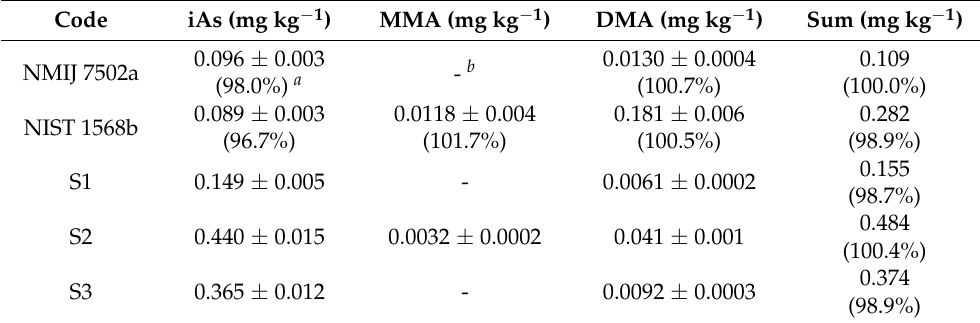
Table 7. Results of Arsenic species in rice flour samples determined using ultrasound-assisted enzymatic